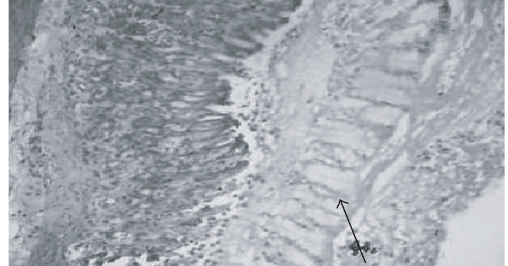
Figure 2: Histological appearance of the gastric ulcers 1hour after ethanol treatment. Severe erosion with necrosis of gastric mucosa, detachment of necrotic gastric mucosa (arrow) H&E magnification, X 250.